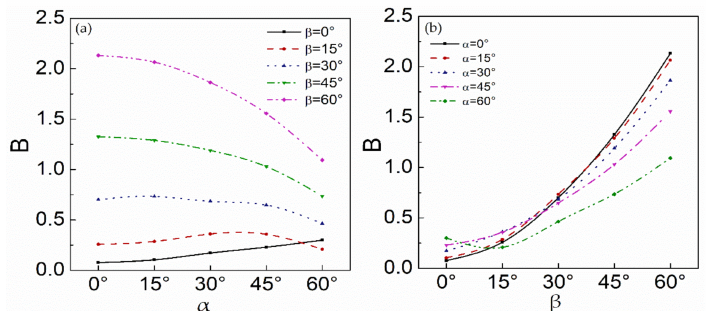
Figure 8. Variation of biaxiality ratio B with respect to horizontal deflection angle α and vertical deflection angle β . ( a ) The relationship between B and α . ( b ) The relationship between B and β .